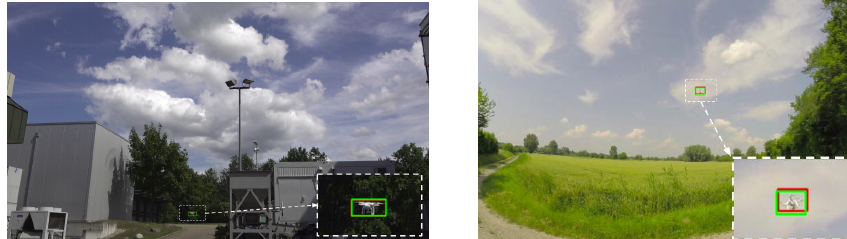
Figure 18. Alexis team approach based on YOLOv3 [39] is able to detect small drones in high resolution images by using an image tiling strategy. Here are some examples of successful detections made by their approach (green: predictions, red: